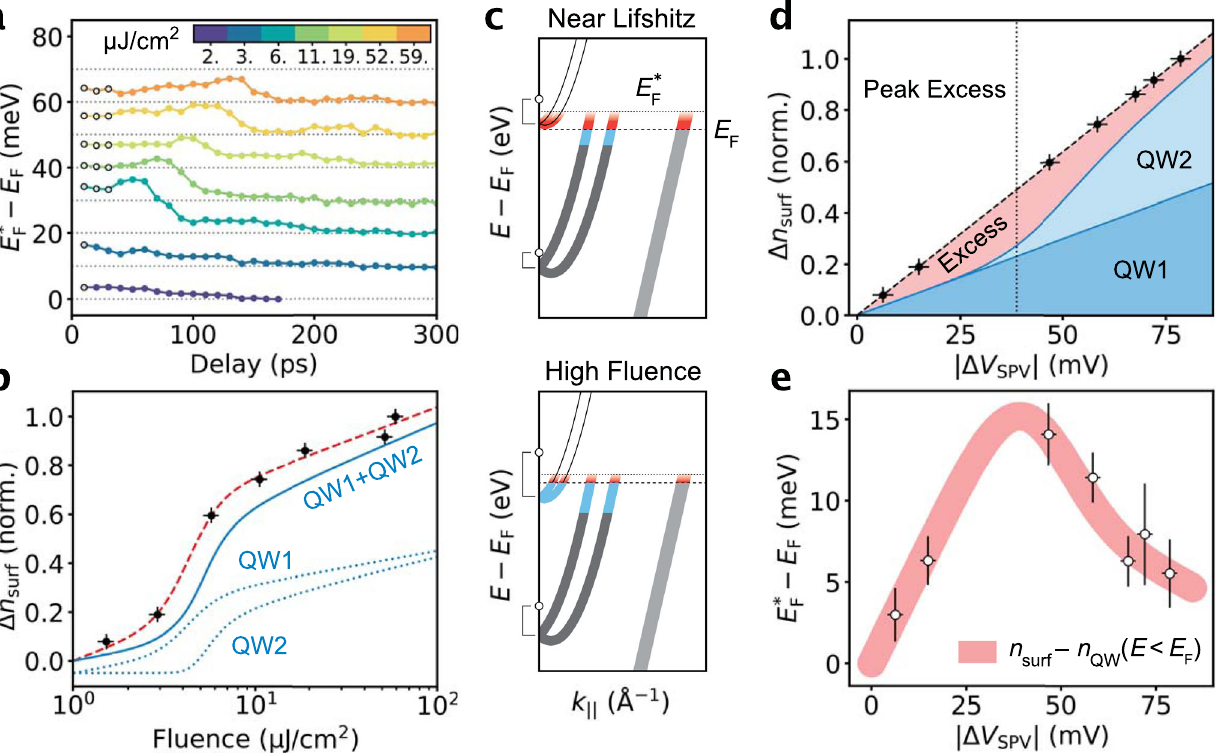
Fig. 5 Competition between surface state trapping and quasi-Fermi level. a Quasi-Fermi level as a function of delay for all fl uences. Outlined points indicate averaged points used in e . b Maximal SPV as a function of fl uence indicating separated charge concentration at the surface. Labeled blue curves demonstrate QW1 and QW2 states below E F determined from the phenomenological fi t (dashed red) and the SPV dependence of the band bottom positions in Fig. 3a. c Graphical comparison of quasi-Fermi level shift between medium and high fl uence. Medium fl uence (3 − 7 μ J cm − 2 ), QW2 photo-carrier generation is signi fi cantly larger than available states in shifted QWs. At high fl uence, photo-carrier generation has saturated and QW2 provides increased storage below E F . d Representation of b with the x axis parameterized by SPV surface potential. Excess carriers after fi lling QW trap states (light-red) contribute to raising E (cid:1) from a and total surface charge minus trapped surface charge (light-red curve)(black dashed curve minus solid blue curve in d ) as a function of surface voltage. Error bars for Δ n and Δ V SPV are conservative 10% and 2.5 meV, respectively. Y axis error in e determined by difference measured at QW1 and TSS k F between E (cid:1) F